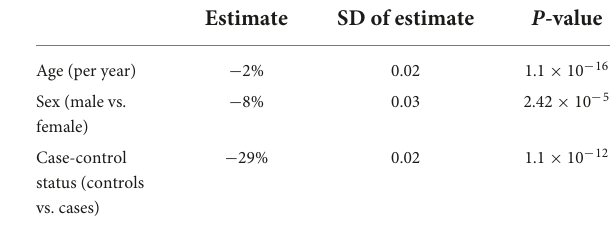
TABLE 2 Telomere length comparison between people with amyotrophic lateral sclerosis (ALS) and healthy controls using a generalized linear